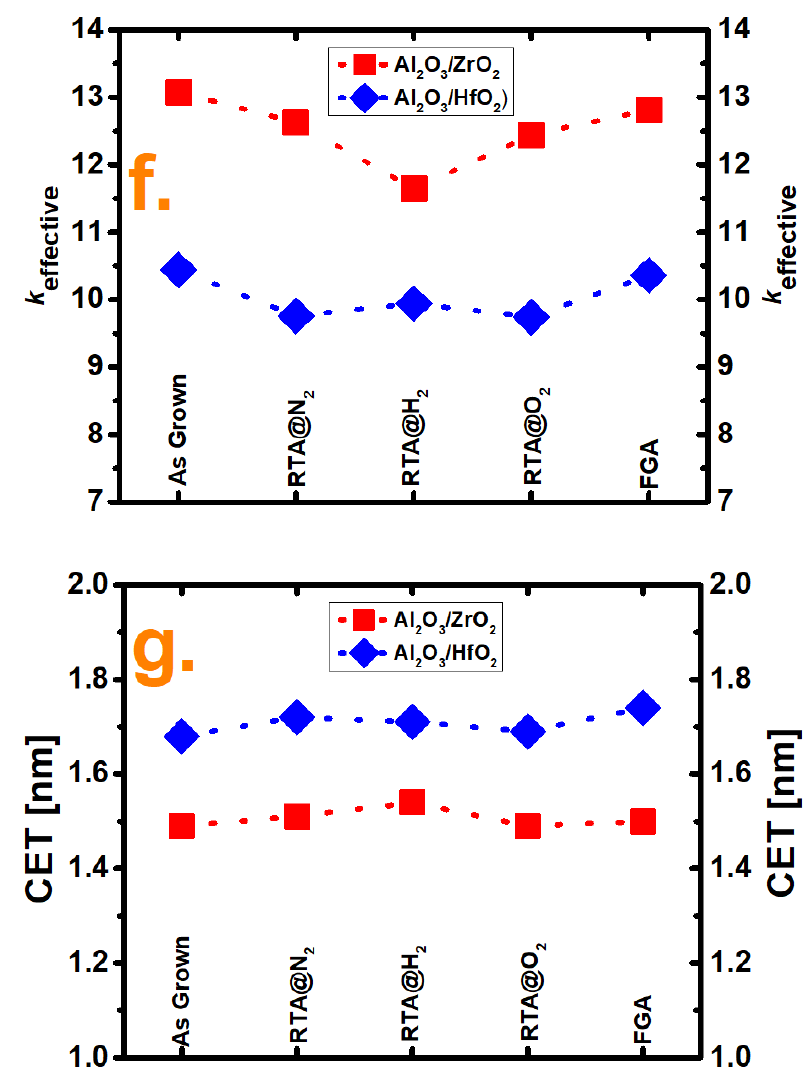
Figure 1. ( a – e ) Frequency dispersion (1 kHz–1 MHz) capacitance voltage (C–V) response of Al 2 O 3 / ZrO 2 Figure 1. ( a–e ) Frequency dispersion (1 kHz – 1 MHz) capacitance voltage (C – V) response of and Al 2 O 3 / HfO 2 respectively, for as-grown and di ff erent post-metal annealing (PMA) treatment Al 2 O 3 /ZrO 2 and Al 2 O 3 /HfO 2 respectively, for as-grown and different post-metal annealing (PMA) conditions, at applied gate voltages ranging from − 1.5 to + 1.5 V. ( f ) E ff ective dielectric constant ( k e ff ective ) and ( g ) capacitance equivalent thickness (CET) comparison of both samples under